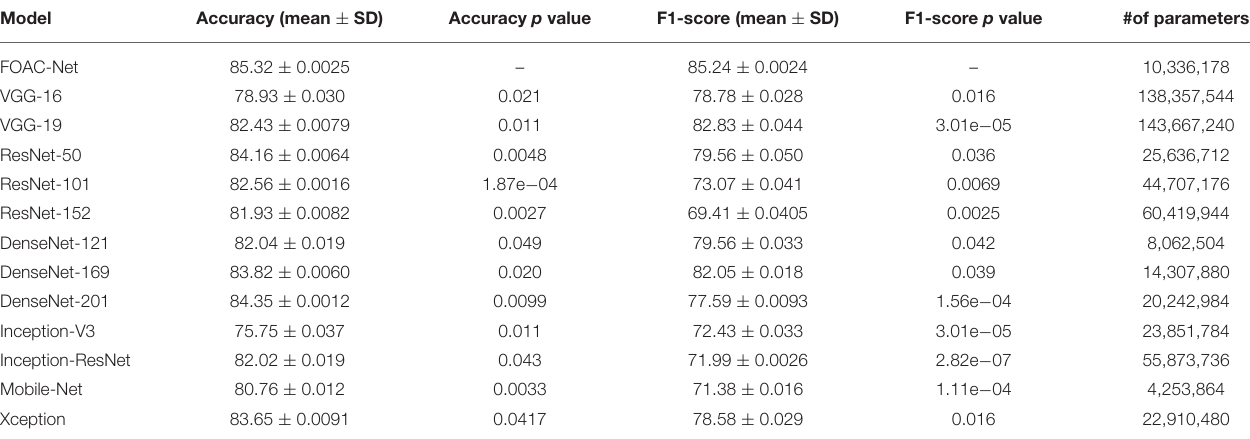
TABLE 2 | Mean testing results with standard deviation.